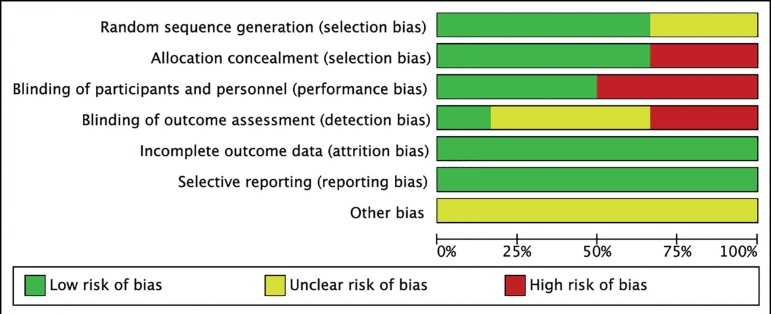
Risk of bias graph